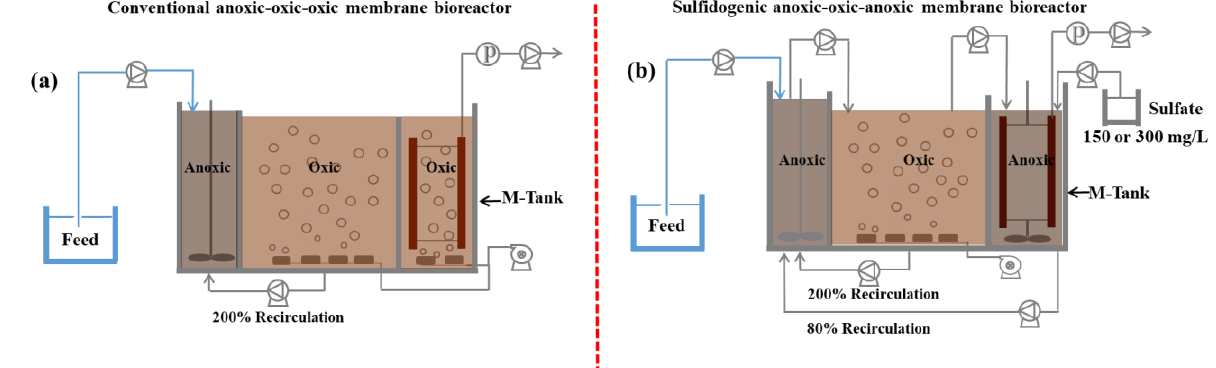
Figure 1. Configuration of conventional ( a ) membrane bioreactor (MBR control ) and ( b )